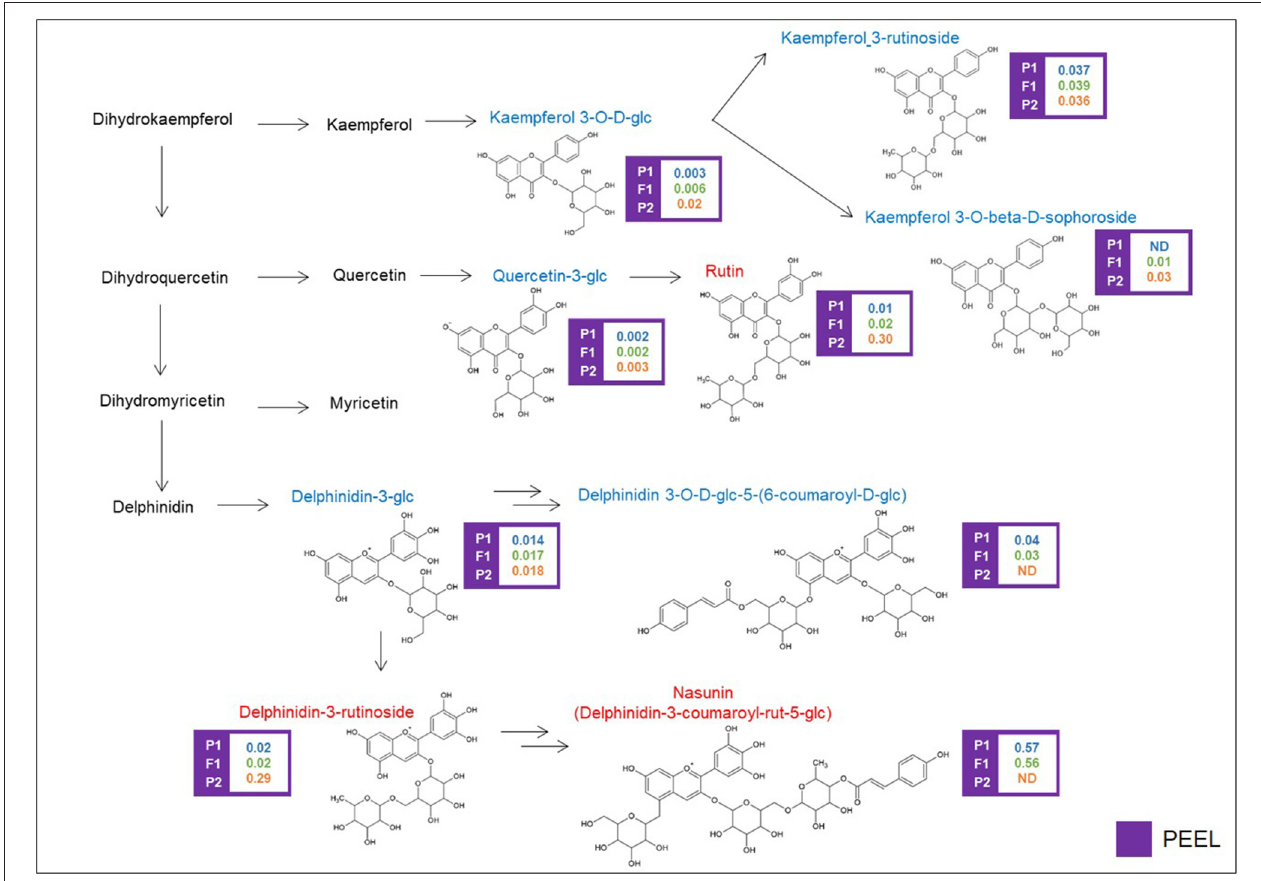
FIGURE 4 | Biosynthetic pathway of flavonoids. Levels of detectable metabolites are expressed as fold/ISTD (Internal Standard: formononetin) in parental lines “67/3” (male) and “305E40” (female) and the F1 progeny. ND, not detectable. Metabolites marked in red have been identified by the untargeted analysis, in blue by the targeted